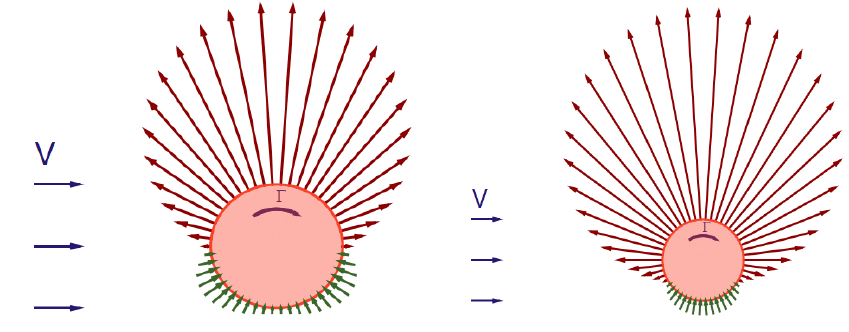
Fig. 7. Distribution of the pressure coefficient on the surface of the cylinder in the case of a circulation flow around a round cylinder, for . (left), for .